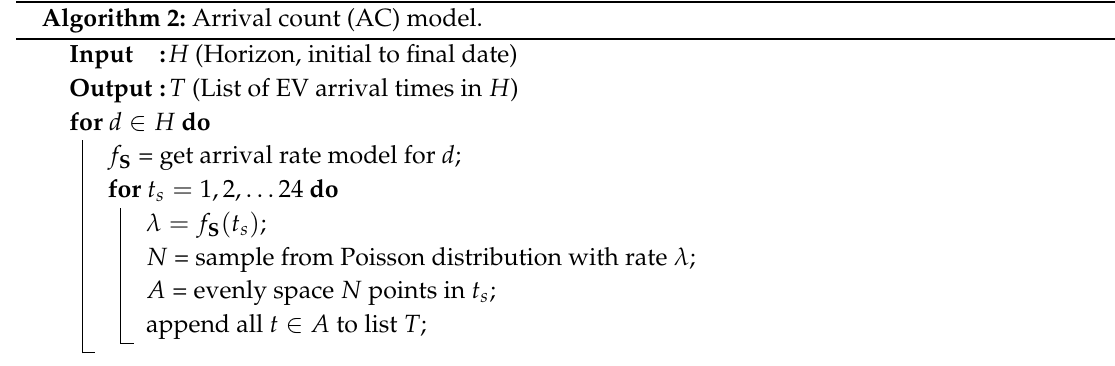
Algorithm 2: Arrival count (AC)